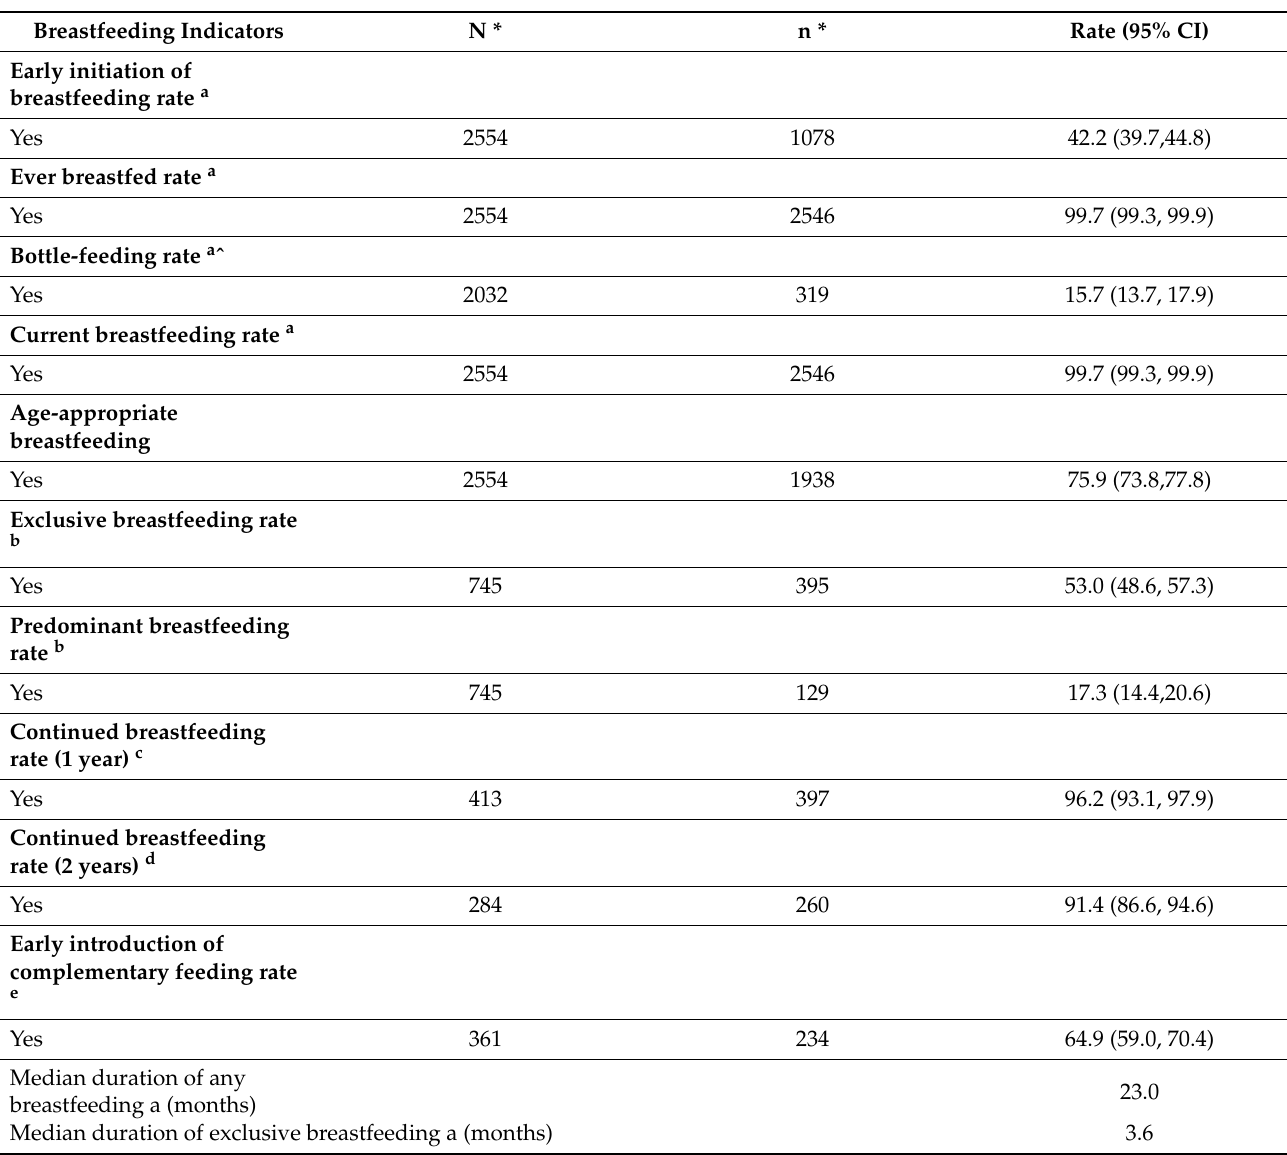
Table 2. Breastfeeding indicators among children 0–23 months of age, Bangladesh 2004–2014 (n = 2554). Breastfeeding